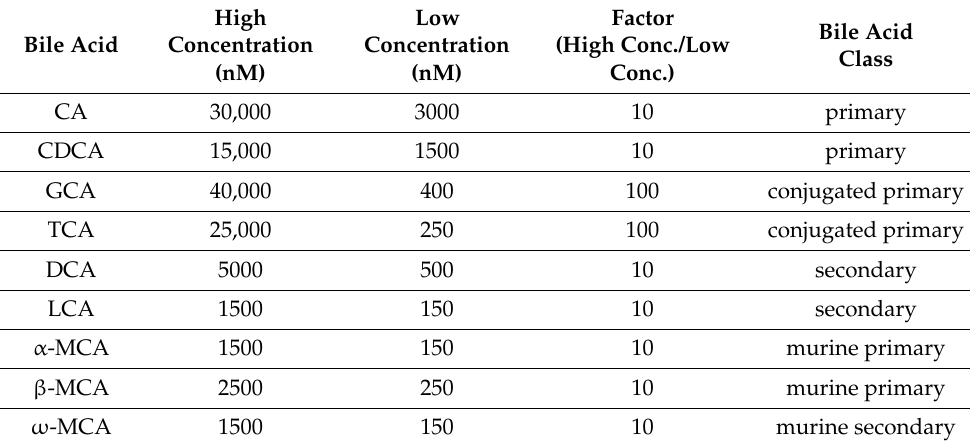
Table 1. List of bile acids and concentrations spiked into the